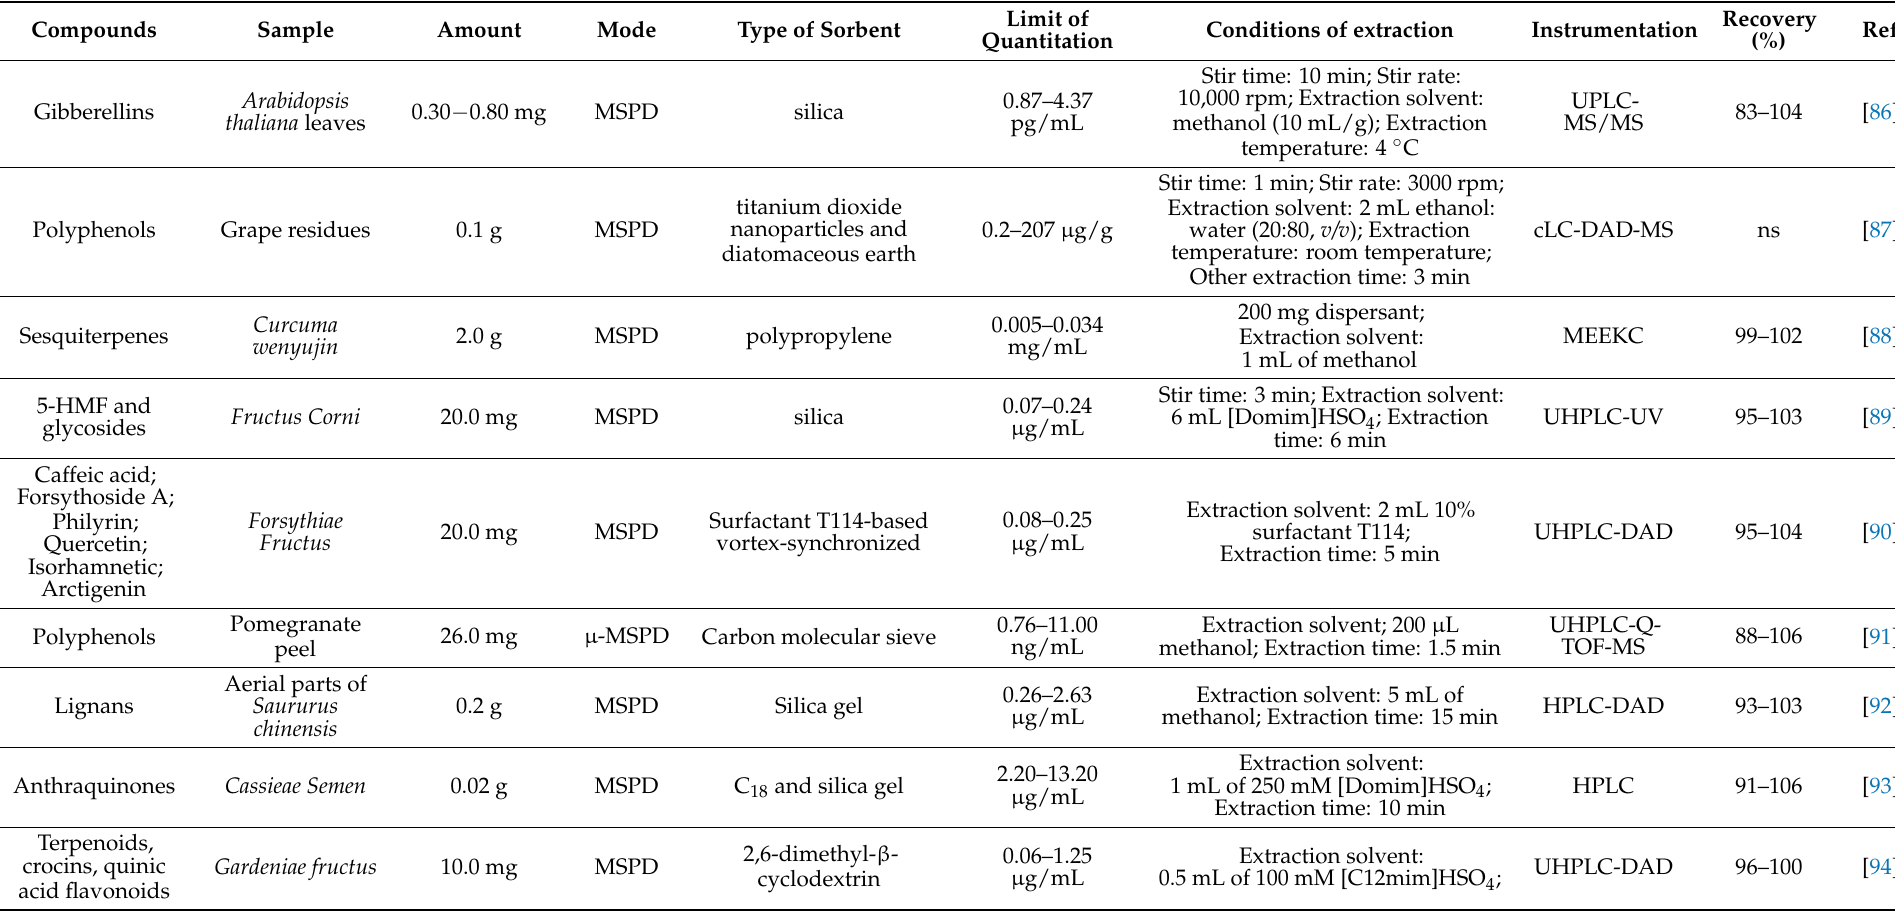
Table 5. Application of MSPD techniques for extraction of several compounds in natural